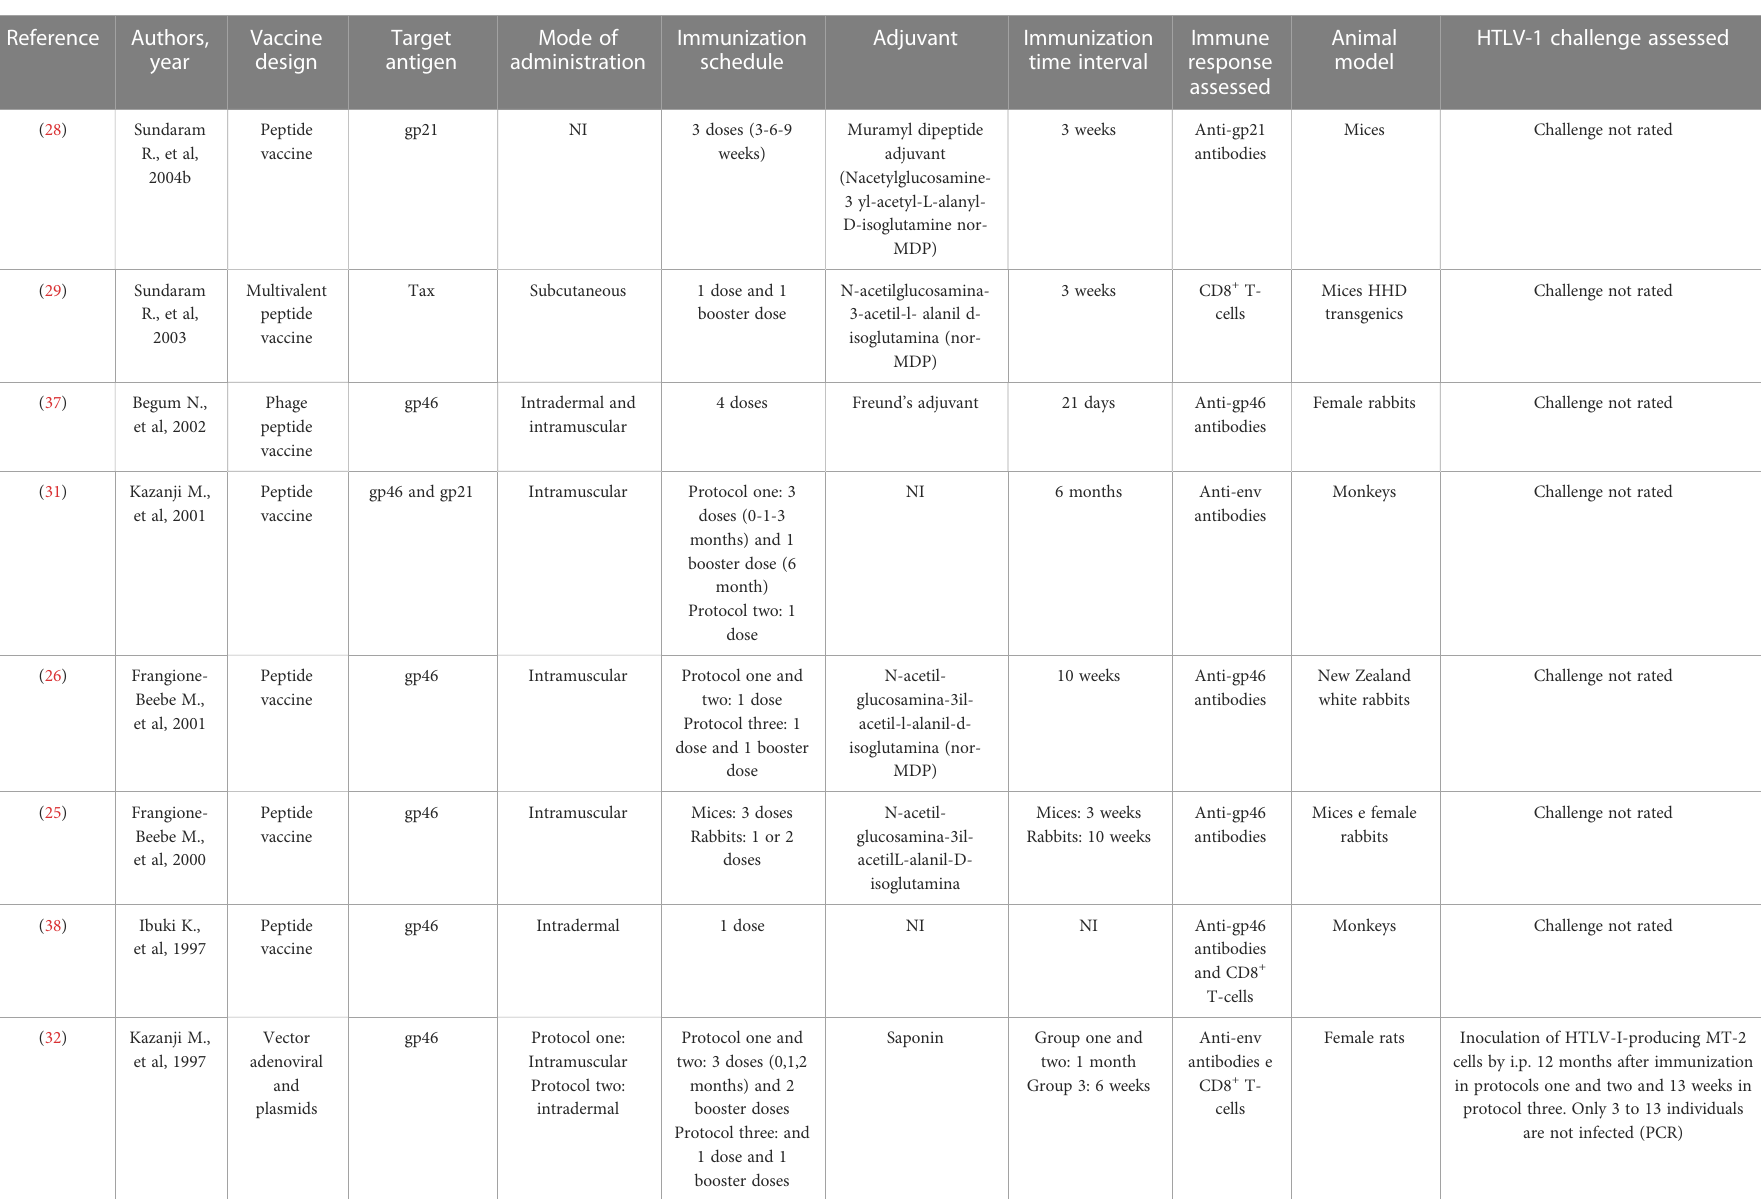
Saponin Group one and